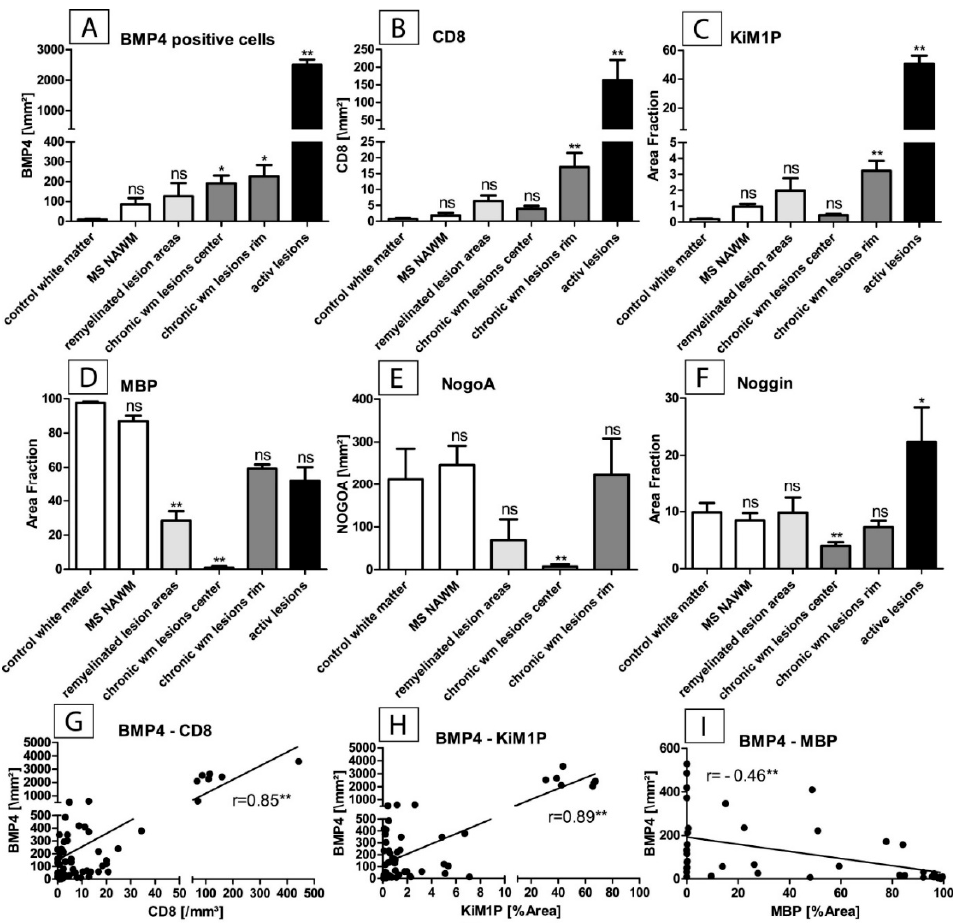
Figure 3. Software-assisted immunohistochemical quantification of BMP4-positive cells associated with the white matter pathology of multiple sclerosis: ( A ) Quantification of immunopositive cells in inflammatory i.e., active lesions, the lesion margin of chronically inactive lesions, the lesion center of chronically inactive lesions, remyelinated lesion sites and normal appearing white matter (NAWM) of MS cases with respect to control tissue (white matter of cases without apparent neurological disease). A significantly increased number of BMP4-positive cells is found in active lesions. A larger number of BMP4-positive cells are also seen in the periphery and center of chronically inactive lesions (** p < 0.01, * p < 0.05, n = 6–18, mean + SEM, ns = not significant). ( B , C ) Quantification of CD8-positive T-cells and the microglial/macrophagocytic infiltrate (CD68 (KiM1P) area fraction) in corresponding lesion areas as described under A. Inflammatory T-cellular infiltrate and microglial/macrophagocytic infiltrate are particularly present in active lesions and in the margins of chronically inactive lesions (** p < 0.01, n = 6–18, mean + SEM, ns = not significant). ( D , E ) Quantification of the abundance of myelin sheaths (detected by staining for the myelin protein MBP; MBP area fraction) and of mature oligodendrocytes (NogoA-staining). Compared to control tissue, myelin sheaths ( D ) are reduced particularly in the chronically inactive lesion centers and also in remyelinated lesion sites (** p < 0.01, n = 6–18, mean + SEM, ns = not significant). The number of mature oligodendrocytes (NogoA-staining, E ) is significantly reduced only in the lesion centers of chronically inactive lesions. In the remyelinated lesion areas, their number has increased again and there is no significant difference compared to control tissue. (** p < 0.01, n = 6–18, mean + SEM, ns = not significant). ( F ) Quantification of the BMP4 antagonist Noggin (area fraction). Increased expression is observed in inflammatory lesions. Especially in lesion centers of chronically inactive lesions, one observes a considerably reduced expression of Noggin. There is a marked difference between the lesion centers of chronically inactive lesions and remyelinated lesion sites in which Noggin expression is restored. Both the inflammatory T-cellular infiltrate and the microglial infiltrate correlate with the number of BMP4-positive cells (** p < 0.01, r = 0.85 ( G ), and r = 0.89 ( H )). A negative correlation between BMP4 expression and myelin sheathing is observed (** p < 0.01, r = − 0.46 ( I